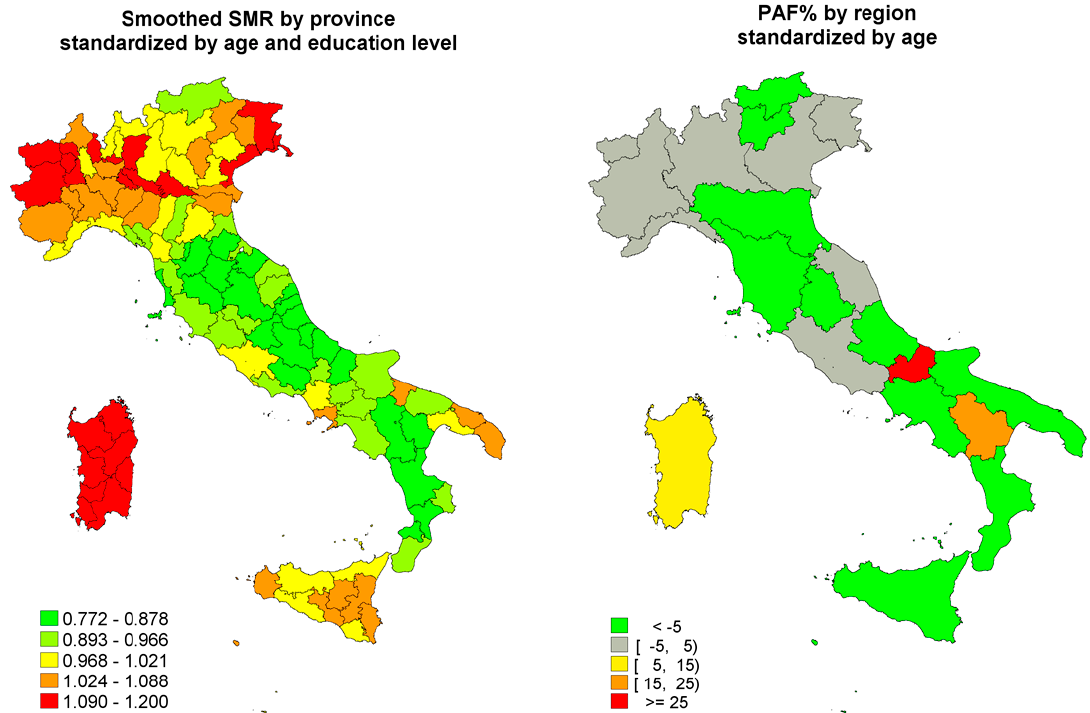
Figure 1. Age-standardised mortality rates (SMR; left) and population attributable fraction (PAF; right) of breast cancer in Italy, by region, age (age range 30–89 years) and education level [23]. Courtesy of Epidemiologia & Prevenzione, Inferenze.